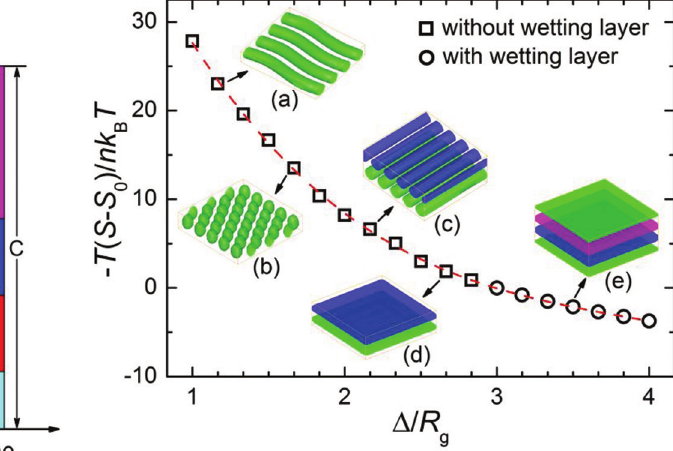
Figure 6: Hybrid morphologies of block A ( f the morphology deliberately made for better observing the interior of hybrid structure.